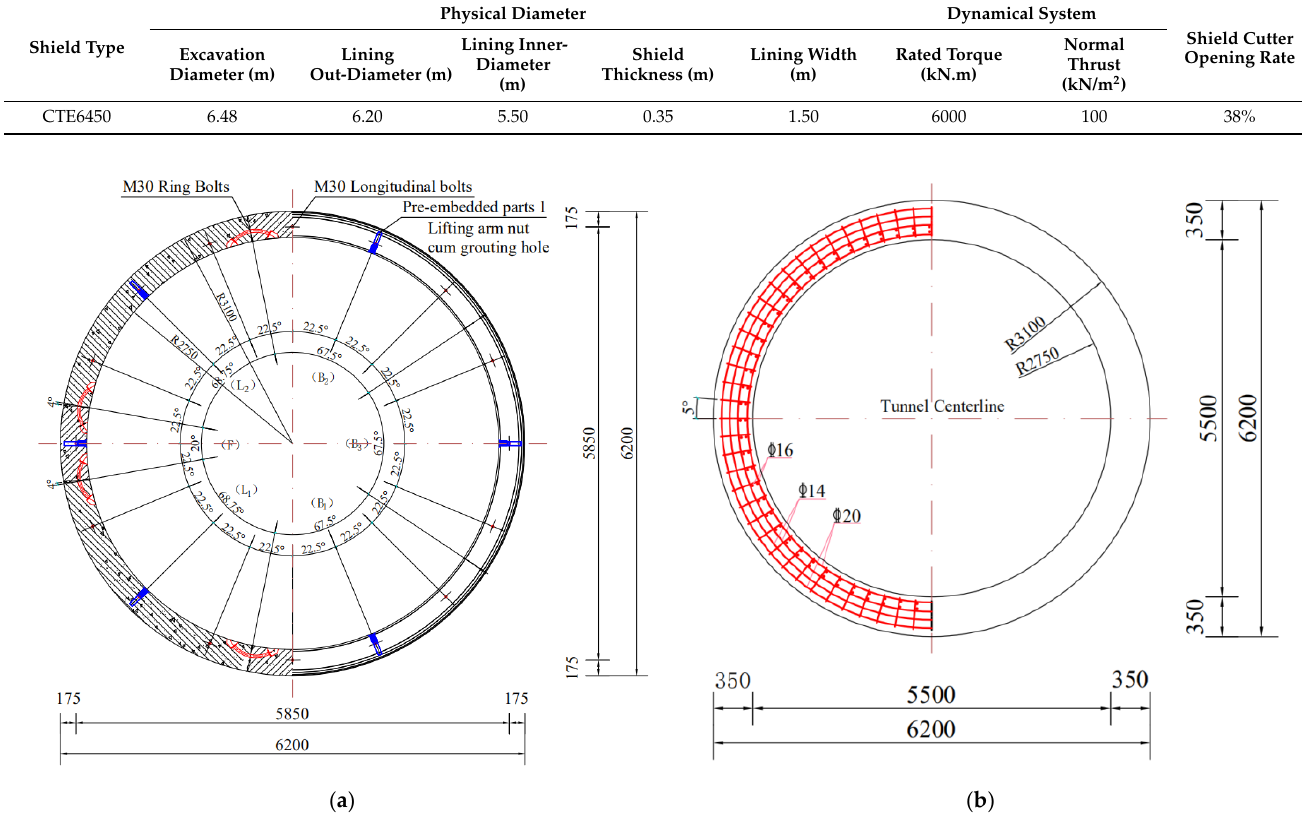
Table 2. Geometric and technical parameters of the shield.